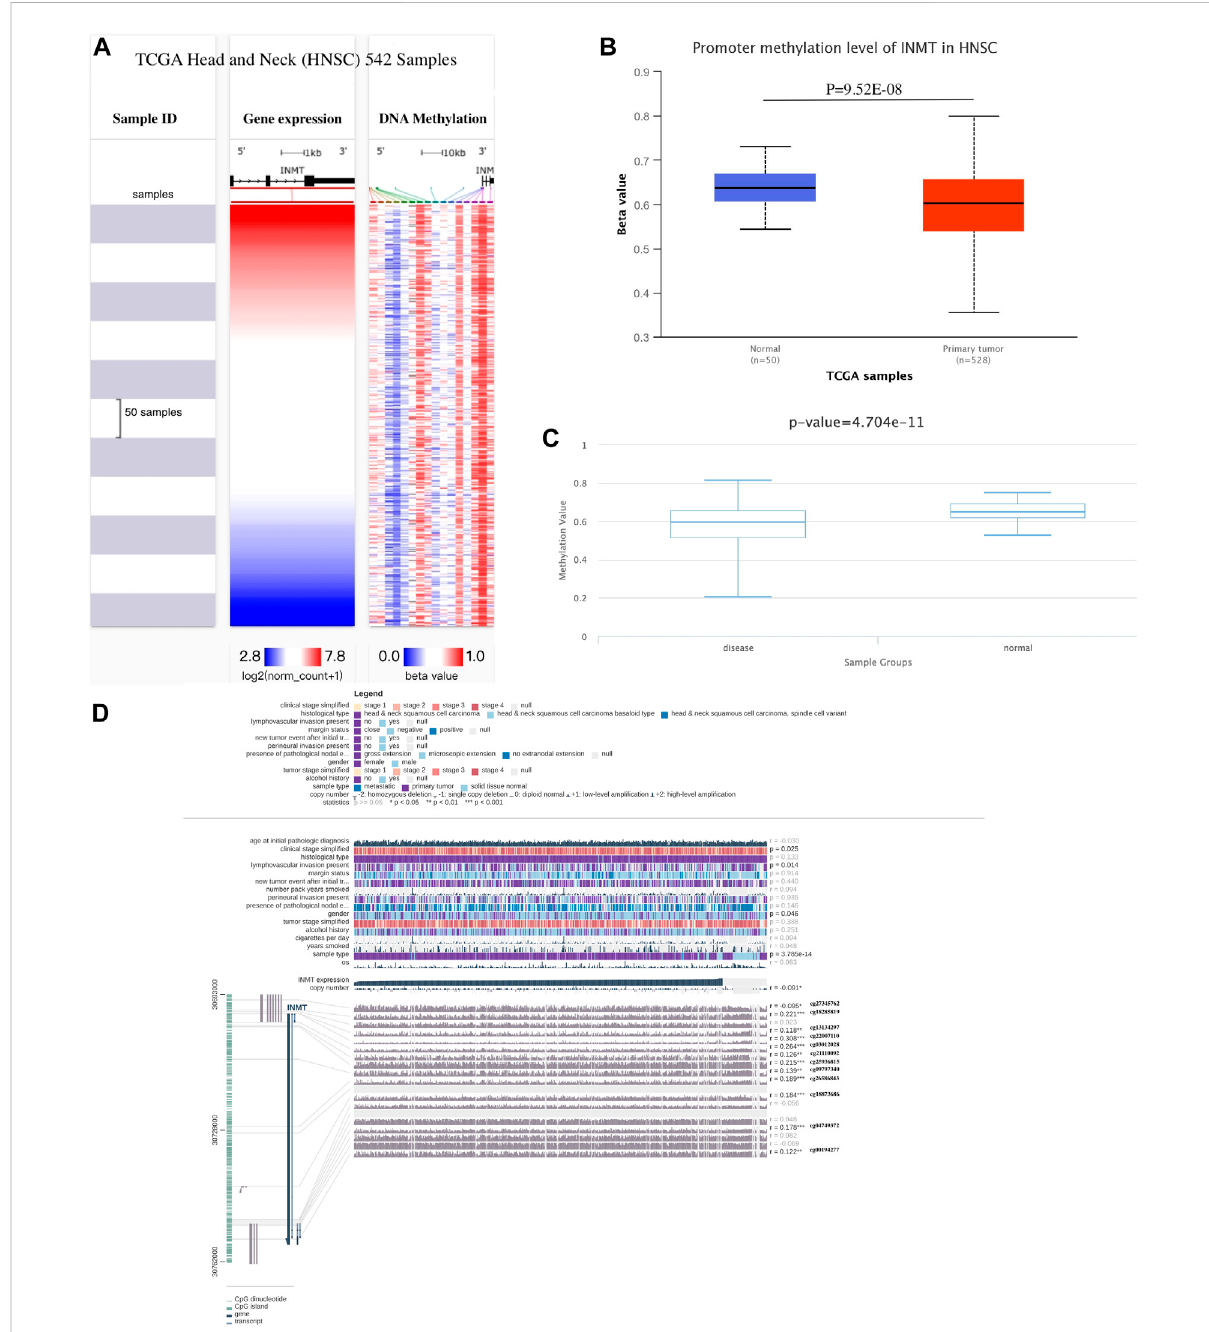
FIGURE 6 Methylation analysis of INMT. (A) Heatmap illustrating the correlations between INMT mRNA and methylation in HNSC as determined by UCSC Xena. (B) Methylation was assessed via UALCAN. (C) DiseaseMeth version 2.0 was used to determine methylation. (D) Methylation of the INMT